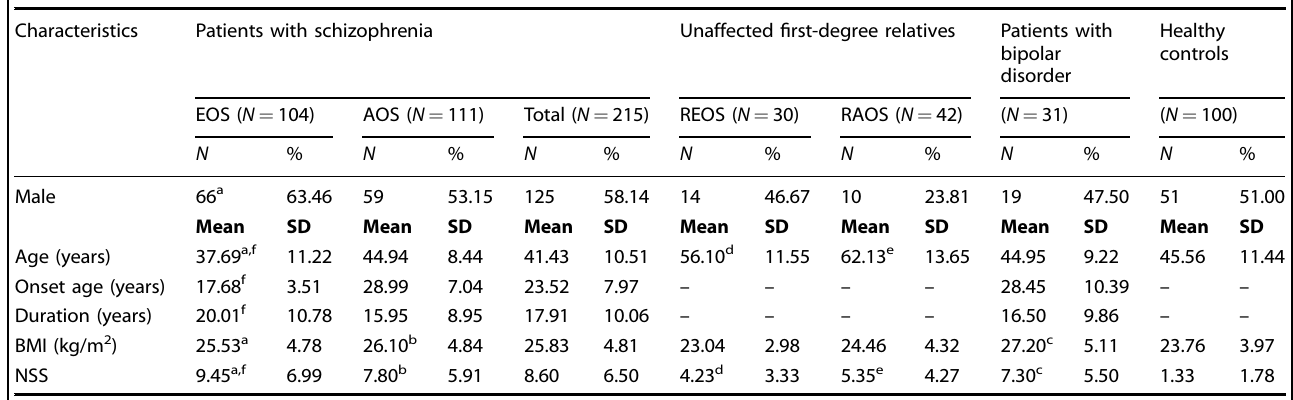
Table 1. Demographic characteristics and clinical pro fi les of